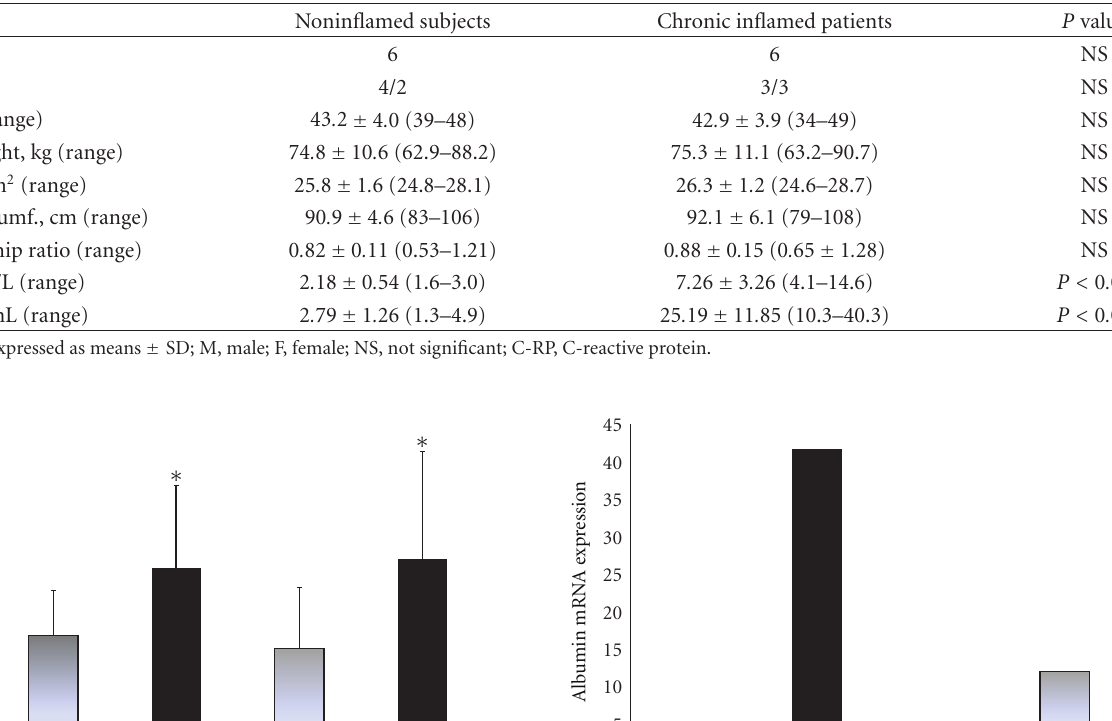
Table 2: Demographic and anthropometric characteristics of the 12 subjects who underwent the adipose tissue biopsy.